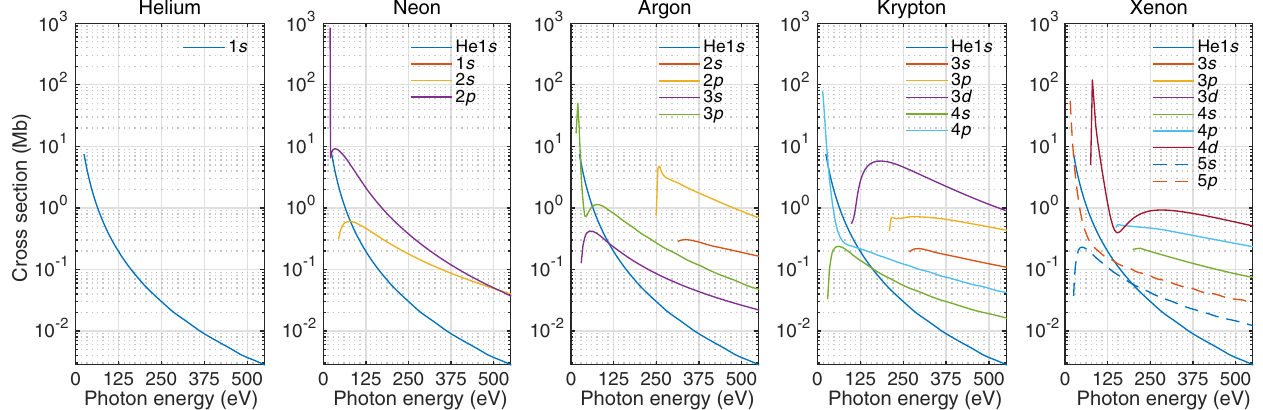
FIG. 1. Photoionization cross sections [58] for the typically used target gases in attosecond streaking experiments. Helium 1 s cross section is included in dark blue in each plot as a point of